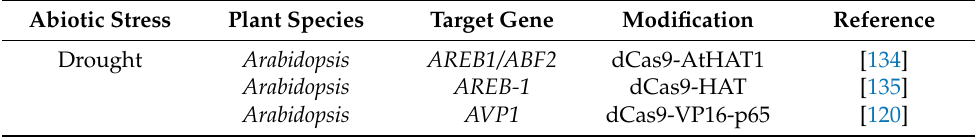
Table 3. Application of CRISPR/dCas9 on abiotic stresses in